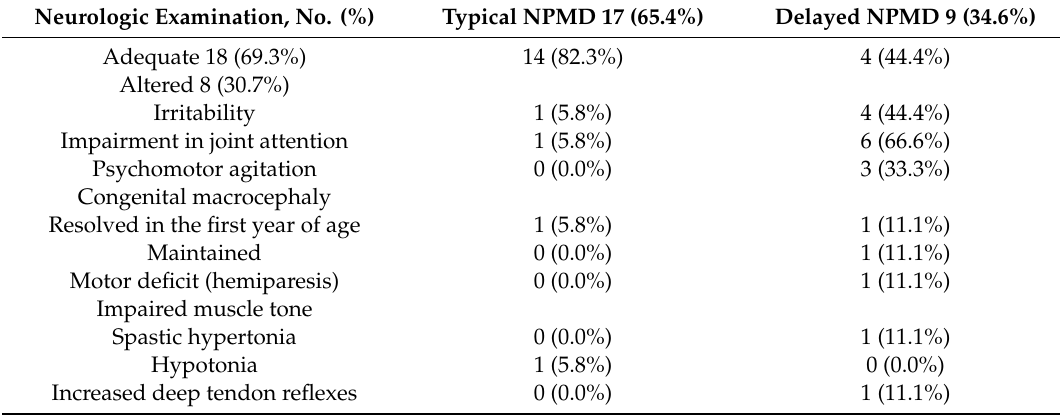
Table 3. Characteristics related to neurological examination and the performance in the BSID-III evaluation for 26 non-microcephalic children exposed to the Zika virus in the intrauterine period, Manaus, Amazonas